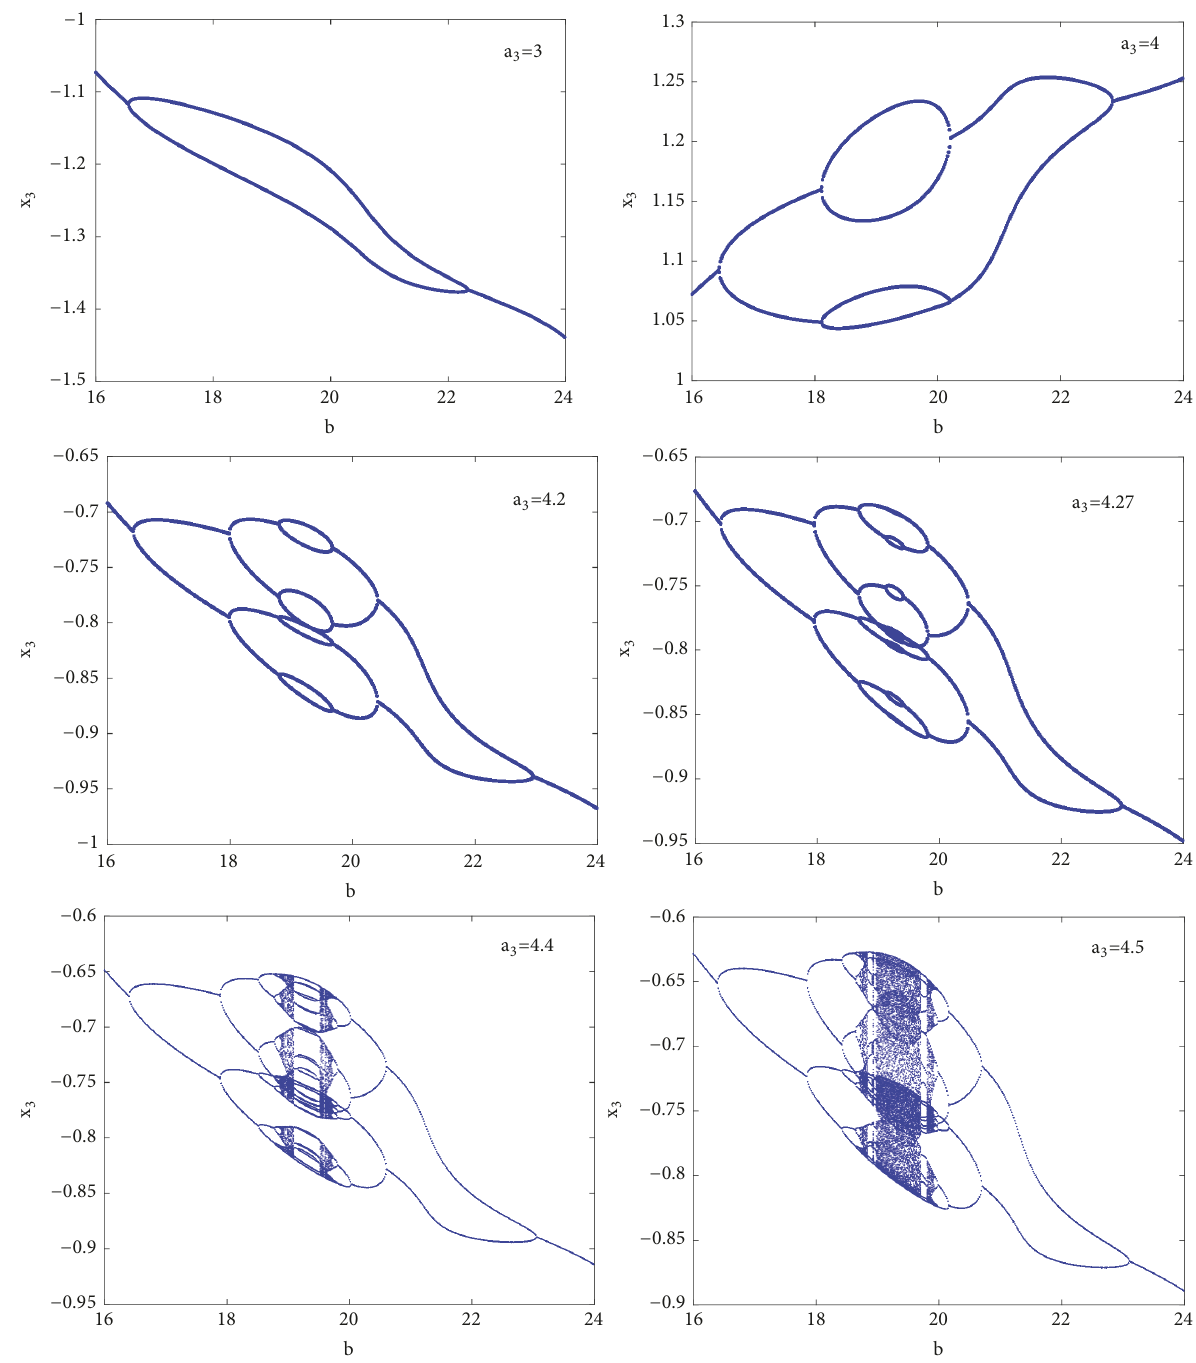
Figure 4: Bifurcation diagrams showing local maxima of the coordinate 𝑥 3 of the attractor in Poincar´e cross section in terms of the control parameter a 2 for remerging Feigenbaum tree (bubbling): period-2 bubble for a 3 = 3, period-4 bubble for a 3 = 4, period-8 bubble for a 3 = 4.2, and full Feigenbaum remerging tree at a 3 =